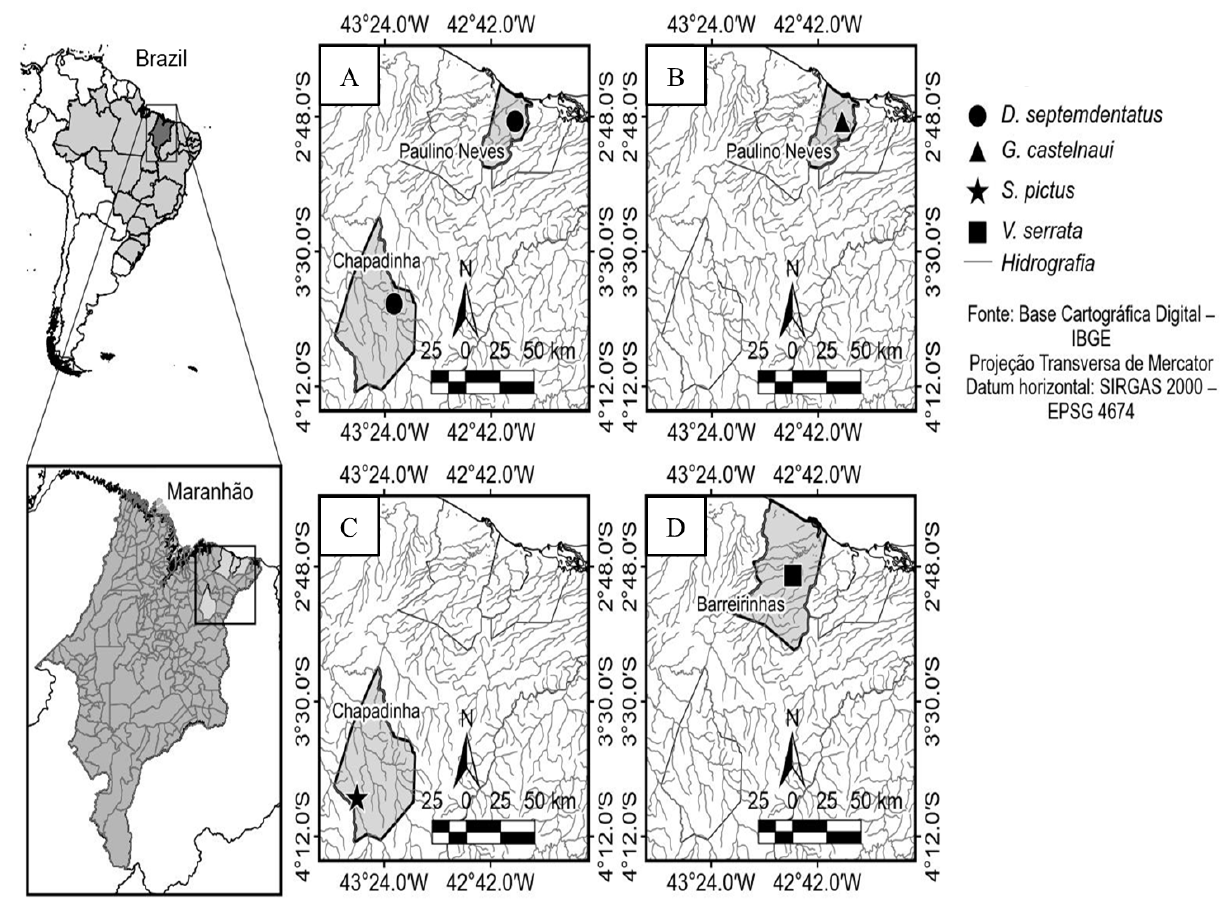
Figure 1. Localities for the new records of trichodactylid crabs in the state of Maranhão, Brazil . A, Distribution of Dilocarcinus septemdentatus; B, distribution of Goyzana castelnaui ; D, distribution of Sylviocarcinus pictus ; D, distribution of Valdivia serrata